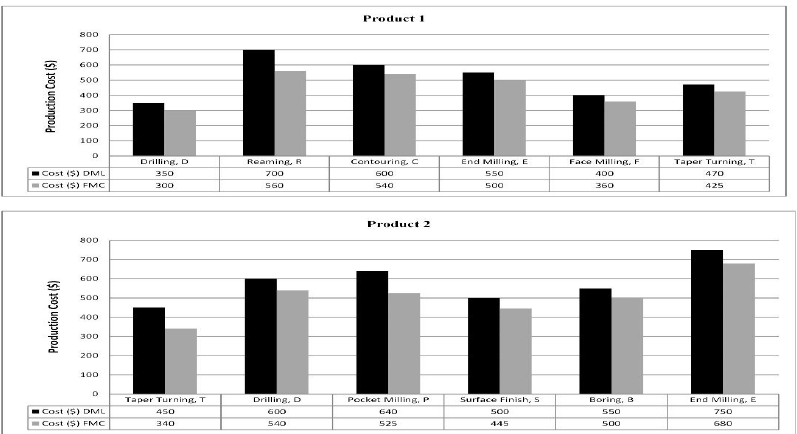
Fig. 4: Comparison of cost indices between DMS and FMS